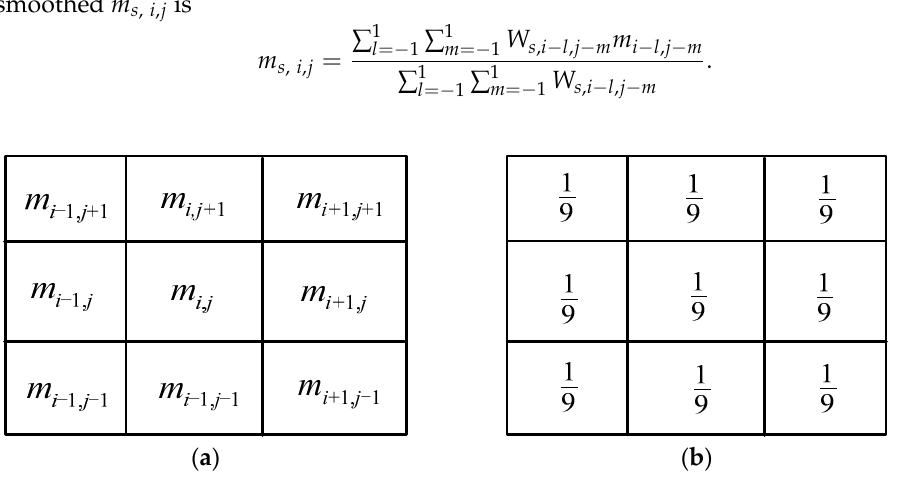
Figure 1. The square-shaped window of m i , j . ( a ) The adjacent elements of m i , j , ( b ) the weight of adjacent position parameters of m i , j